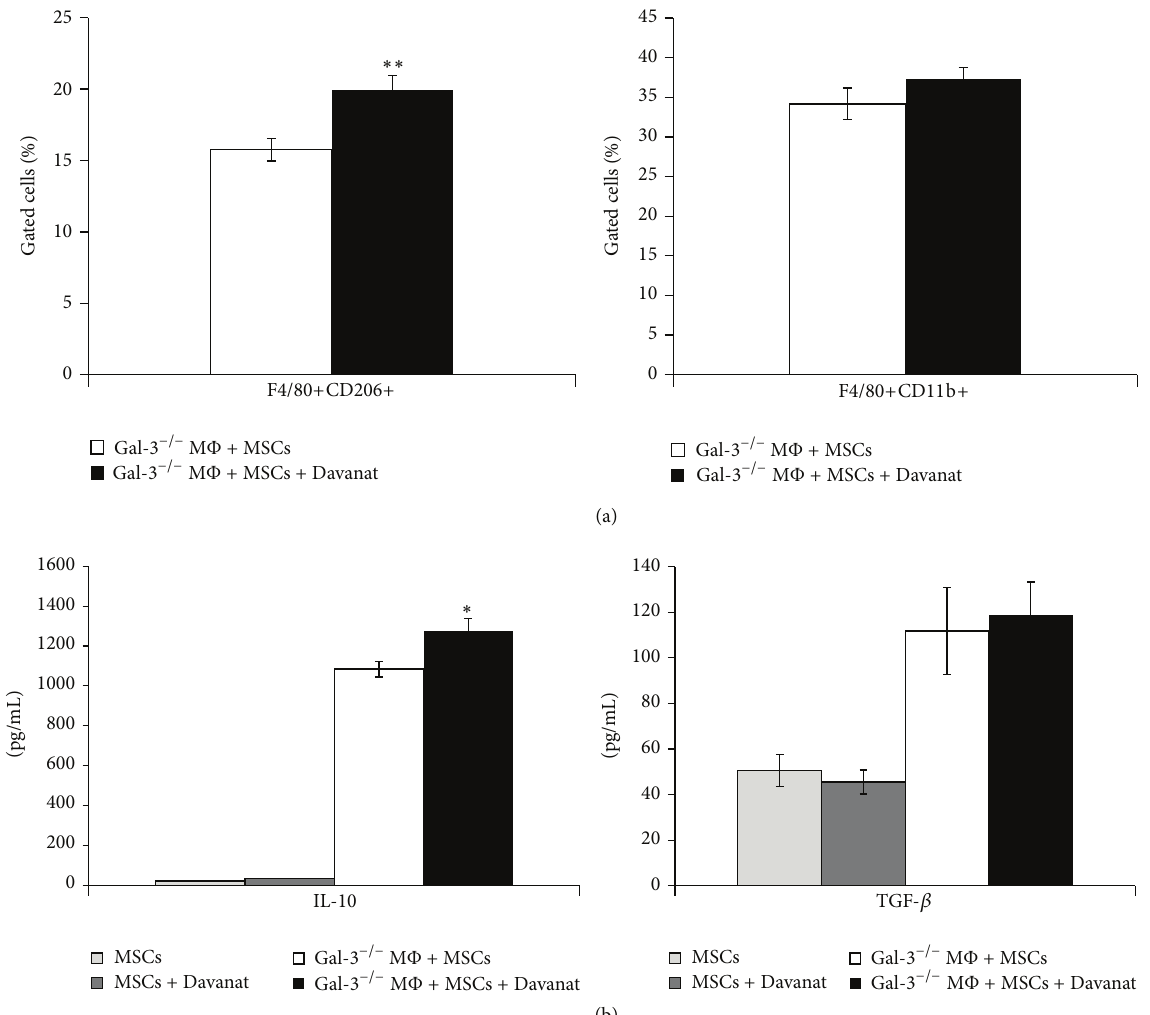
Figure 4: Pharmacological inhibition of Gal-3 in MSCs enhances their capacity to promote alternative activation of peritoneal macrophages. The significant increase in percentage of F4/80+CD206+ macrophages in MSCs + Davanat-treated Gal-3 −/− macrophages (black bars), when compared to only MSCs-treated Gal-3 −/− macrophages (white bars) (a). The percentage of F4/80+CD11b+ macrophages is shown (a). Representative flow cytometry dot plots are shown. The level of IL-10 and TGF- 𝛽 in supernatants (b). Values are mean ± SEM ( 𝑛 = 10 per group). ∗ 𝑃 < 0.05 , ∗∗ 𝑃 < 0.01